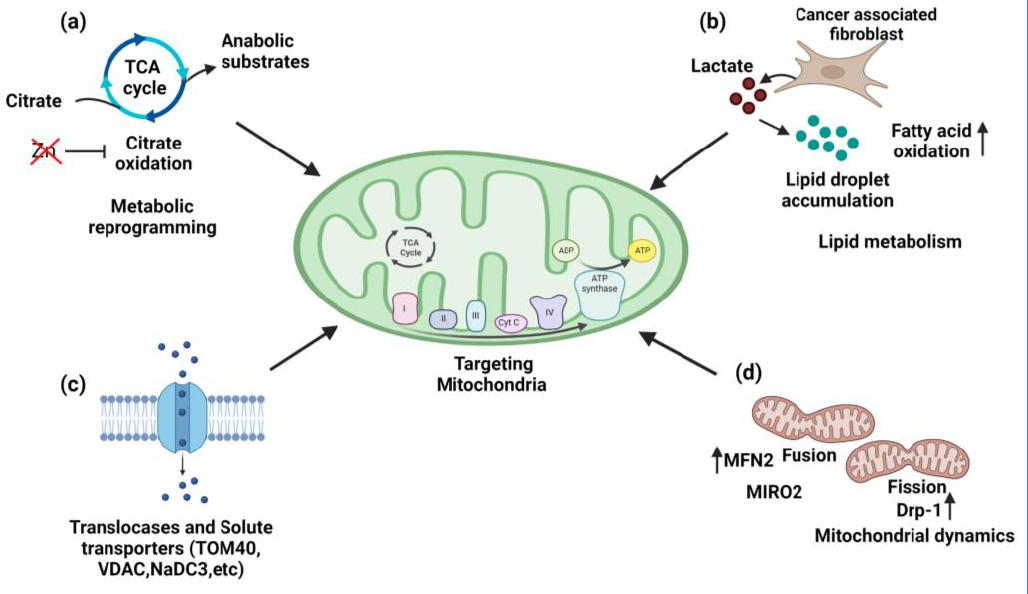
Figure 3. Potential mitochondria targeting strategies in prostate cancer. ( a ) Citrate oxidation is important for transformation of PCa cells, and blocking it could be a first step in treatment of PCa. ( b )